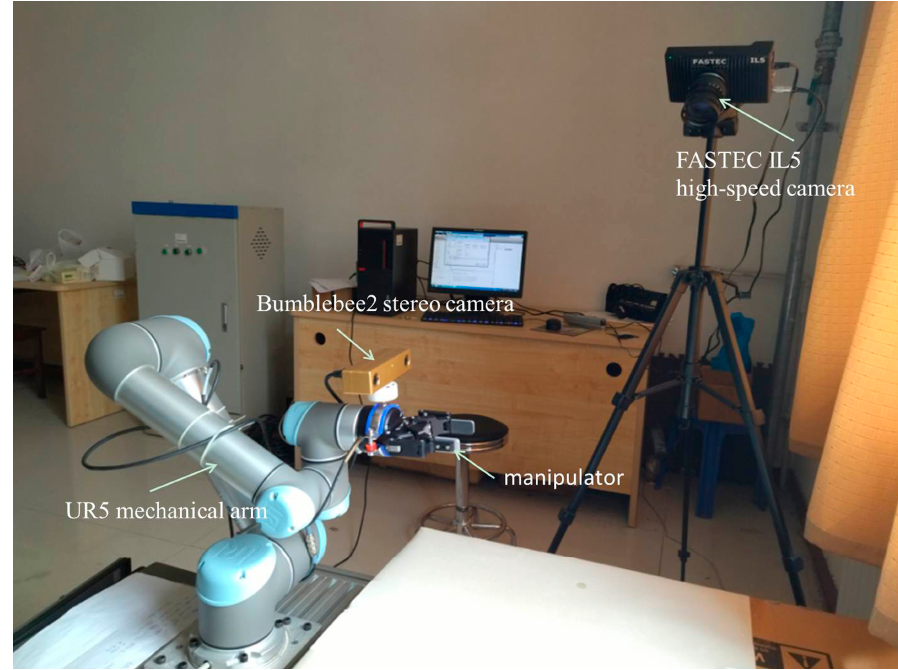
Figure 7. Experimental platform.